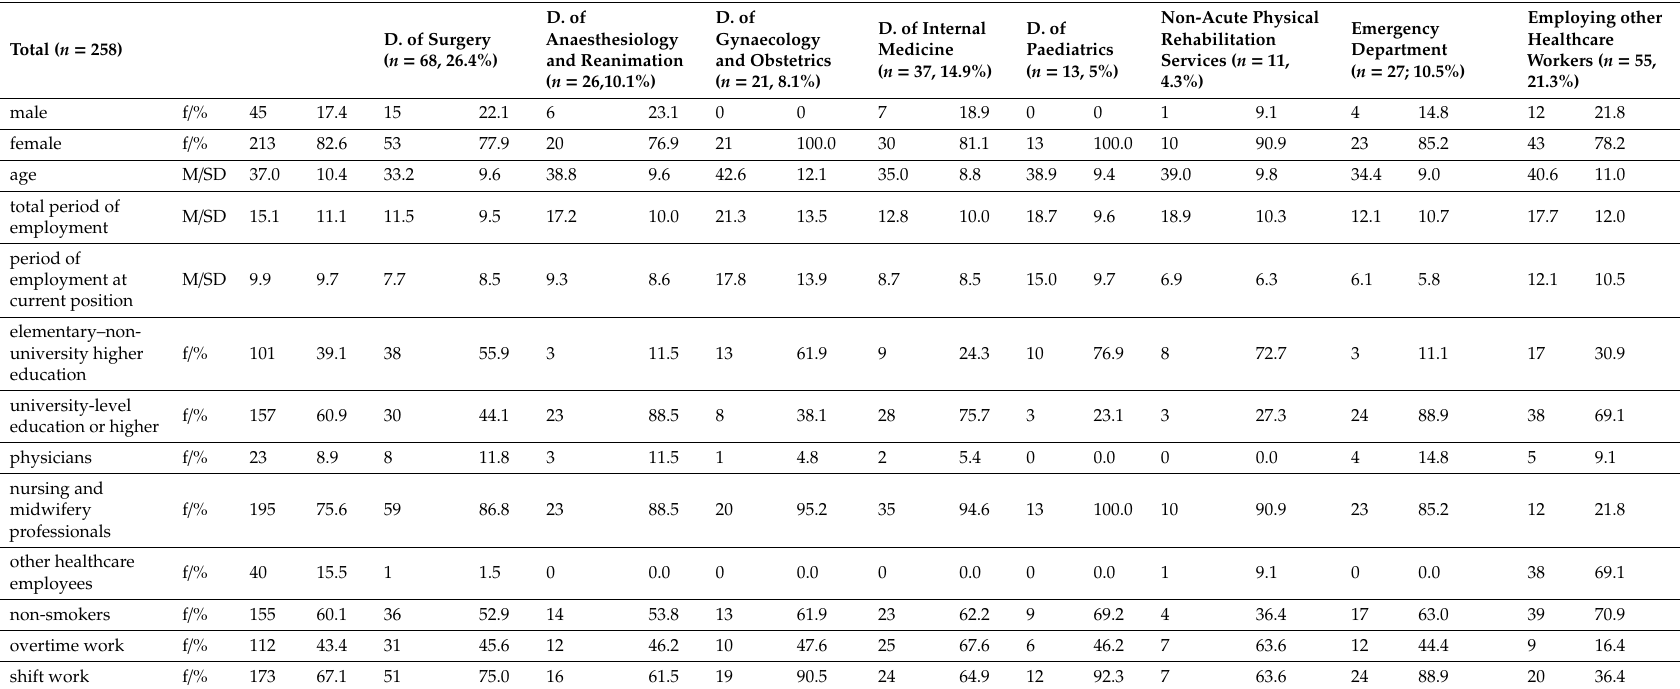
Table 1. General characteristics of healthcare workers at a Slovenian general hospital ( n =